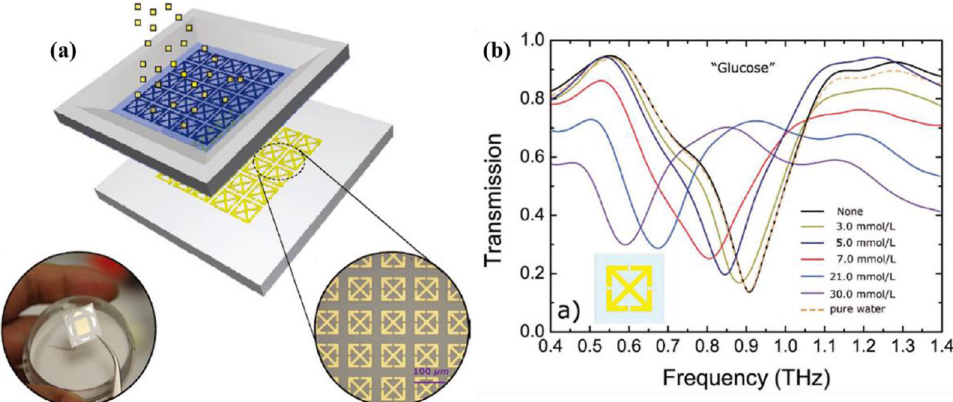
Fig. 8. (a) Schematic diagram and photograph of the paper-based metamaterials. (b) The measured transmission spectra of paper- based metamaterials coated with a series of glucose solutions with different concentration [85]. Reproduced with permission